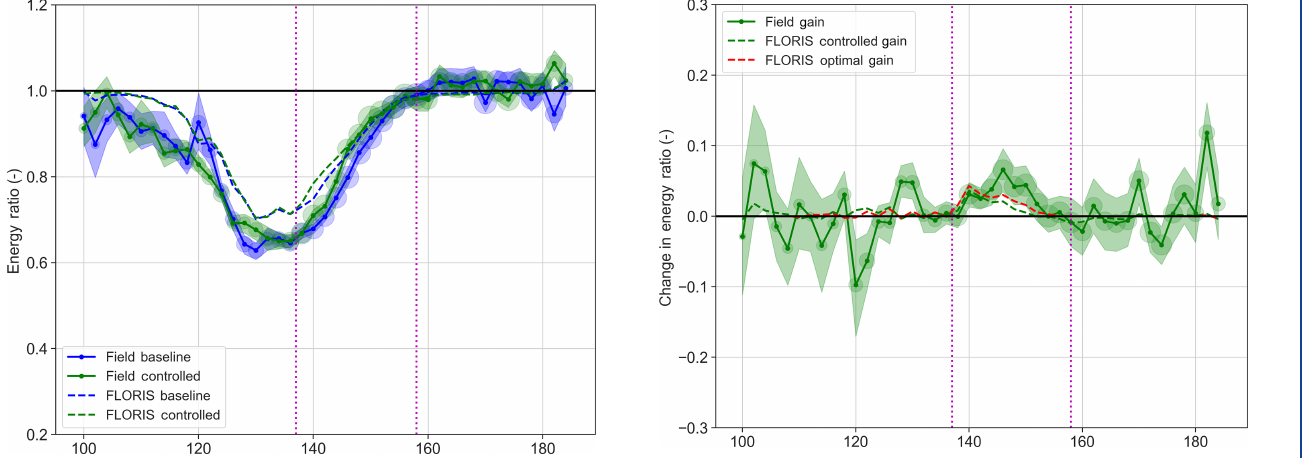
model used to design the applied controllers. The overall gains were consistent with predictions from FLORIS.